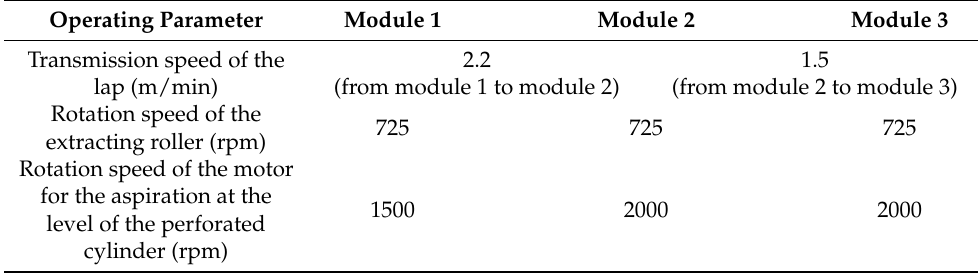
Table 2. Operating parameters used for the “all fibre” extraction device.